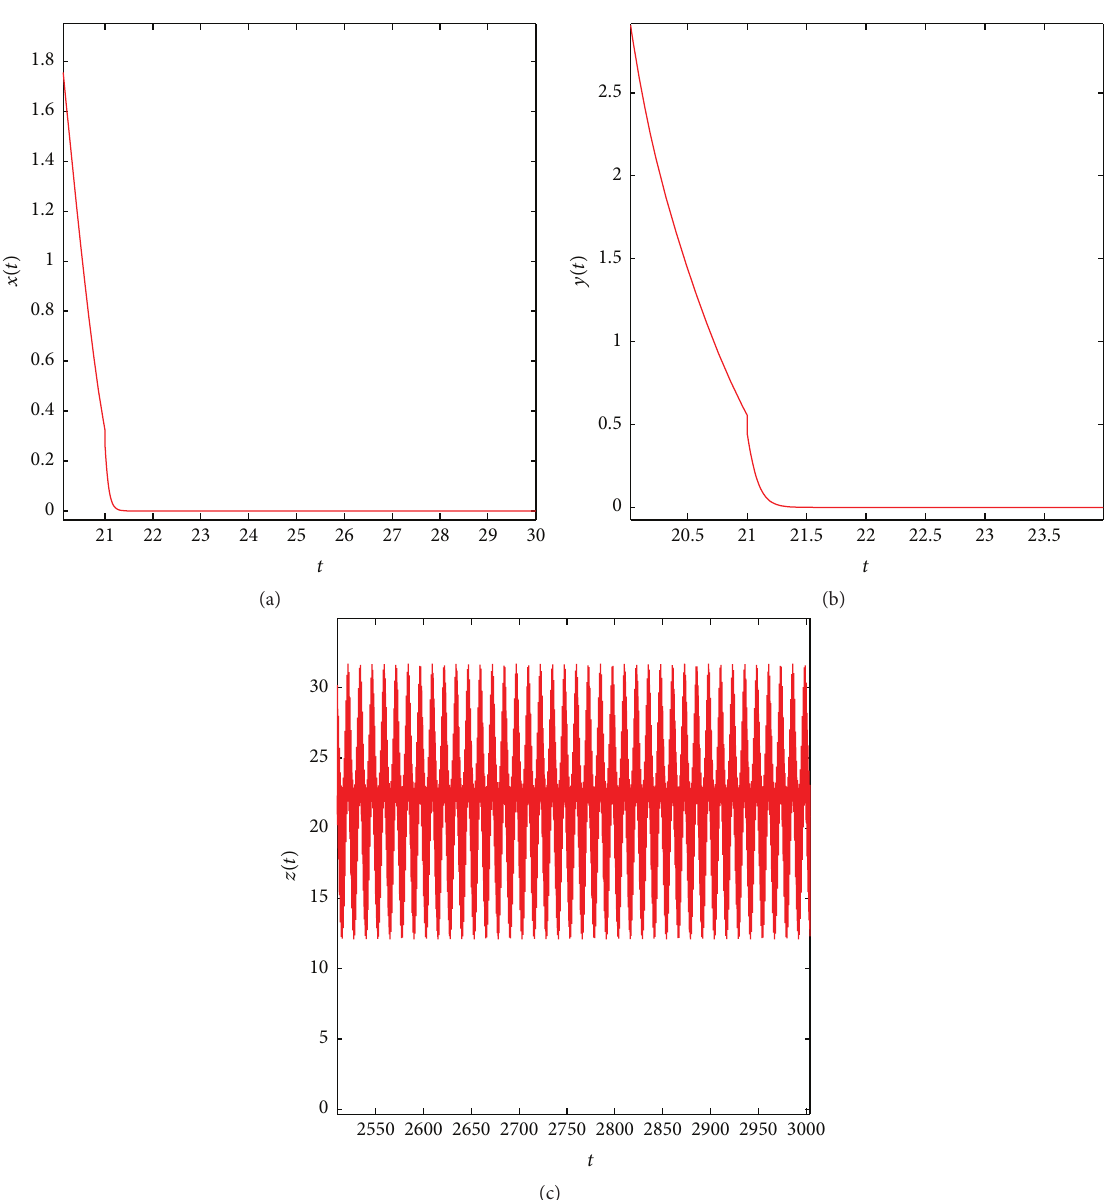
Figure 9: ((a) and (b)) Time series showing extinction of pests 𝑥(𝑡) and 𝑦(𝑡) populations; (c) time series showing high biomass density of 𝑧(𝑡) population of system (2) with mixed Holling type II functional responses ( 𝑝 = 1 , 𝑞 = 1 , 𝑠 = 1 , and 𝑟 = 1 ) in presence of seasonal perturbation with data set (45) and relatively high 𝑃 = 12